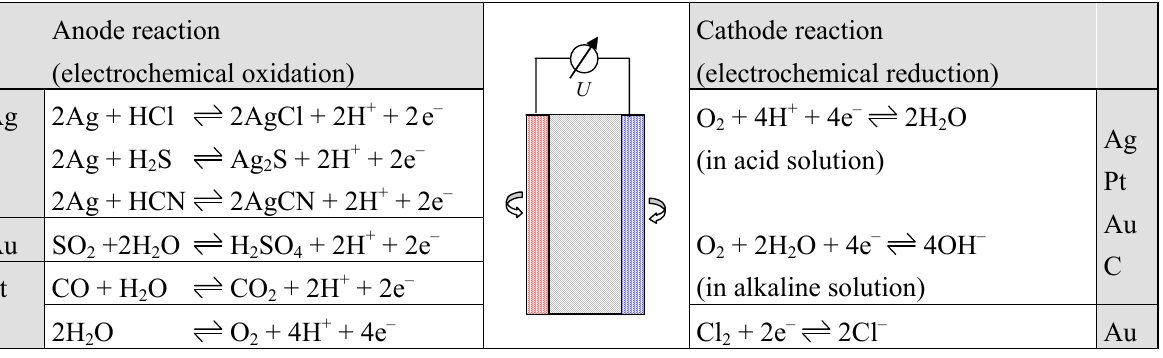
Table 3. Electrode reactions and useful electrode materials for the detection of gases in potentiometric sensors (voltage probe) and amperometric sensors (current